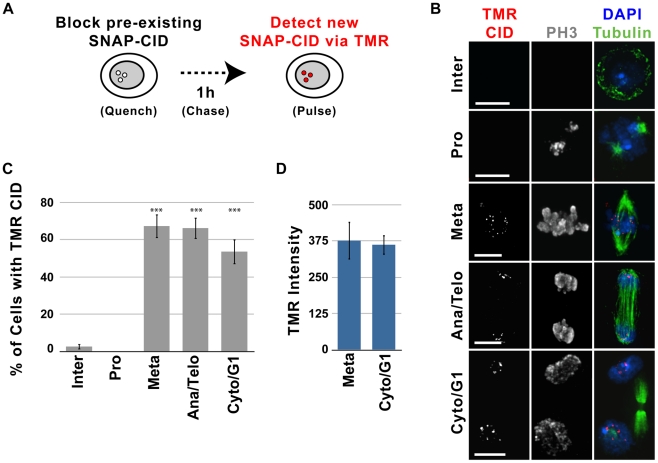
Recruitment of new CID occurs during metaphase in S2 cells.A) Experimental design for monitoring recruitment of new SNAP-CID during mitosis. Clonal S2 SNAP-CID cells were incubated with 12 µM BTP-block to render all pre-existing CID unable to react with TMR. After extensive washes, cells were harvested at different times following the block, and newly-synthesized CID was detected by incubation with TMR. B) Representative images showing recruitment of TMR-CID (red) 2 h after the BTP-block. Centromeric TMR-CID is rarely observed in interphase (Inter), but it is visible in metaphase (Meta), anaphase/telophase (Ana/Telo) and cytokinesis/G1 (Cyto/G1). IF with anti-tubulin (green), anti-phospho H3 (gray), and DAPI (blue) was used to identify specific mitotic stages. Bar = 5 µm. C) Average percent of interphase (n = 113), prophase (n = 37), metaphase (n = 55), anaphase/telophase (n = 29), and cytokinesis/G1 (n = 56) cells displaying centromeric TMR-CID 1 h following the BTP-block (X axis = cell cycle stage, Y axis = percent of cells positive for TMR labeling). New CID recruitment is visible within the first hour following the BTP-block in mitotic cells (*** p<0.0001 compared to interphase, Fisher's exact test). Data for different chase times are shown in Figure S2. D) Quantitative comparison of the TMR-CID intensity at centromeres in metaphase (n = 32) and cytokinesis, (n = 35). Cells in cytokinesis did not show a significant increase in TMR intensity (p = 0.5129, Mann-Whitney test), suggesting that new CID incorporation occurs mainly in metaphase. Bars represent standard error.